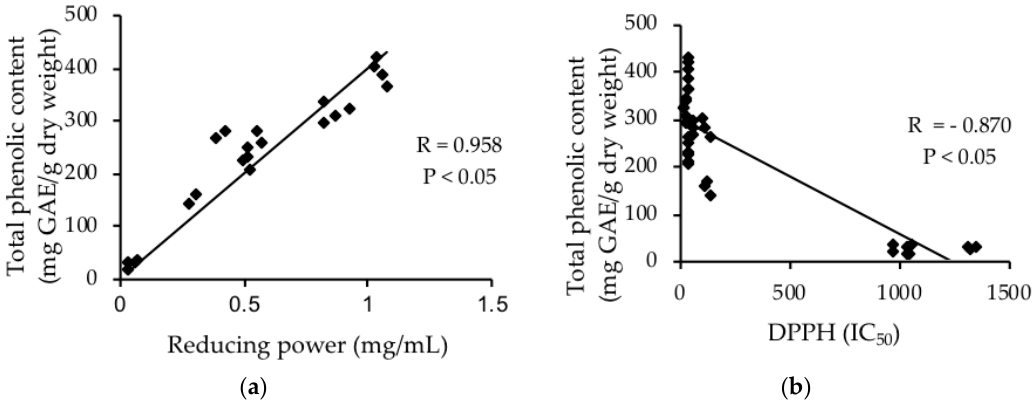
Figure 1. Correlation between total phenolic content and antioxidant capacities measured by DPPH and reducing power in Australian native herbs. ( a ) Correlation between reducing power and total phenolic content; ( b ) Correlation between DPPH and total phenolic content.